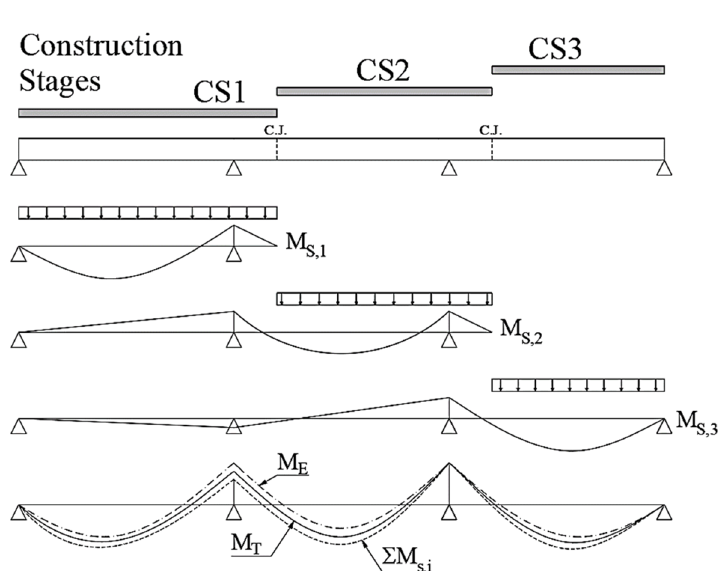
Fig. 1 Schematic showing combination of elastic moments for segmental bridges using span-by-span construction techniques . M T estimated time-dependent moment. M E moment obtained by assuming the entire structure constructed at one same stage. ΣMs,i combination of elastic moments occurring at each construction stage after scaffolding